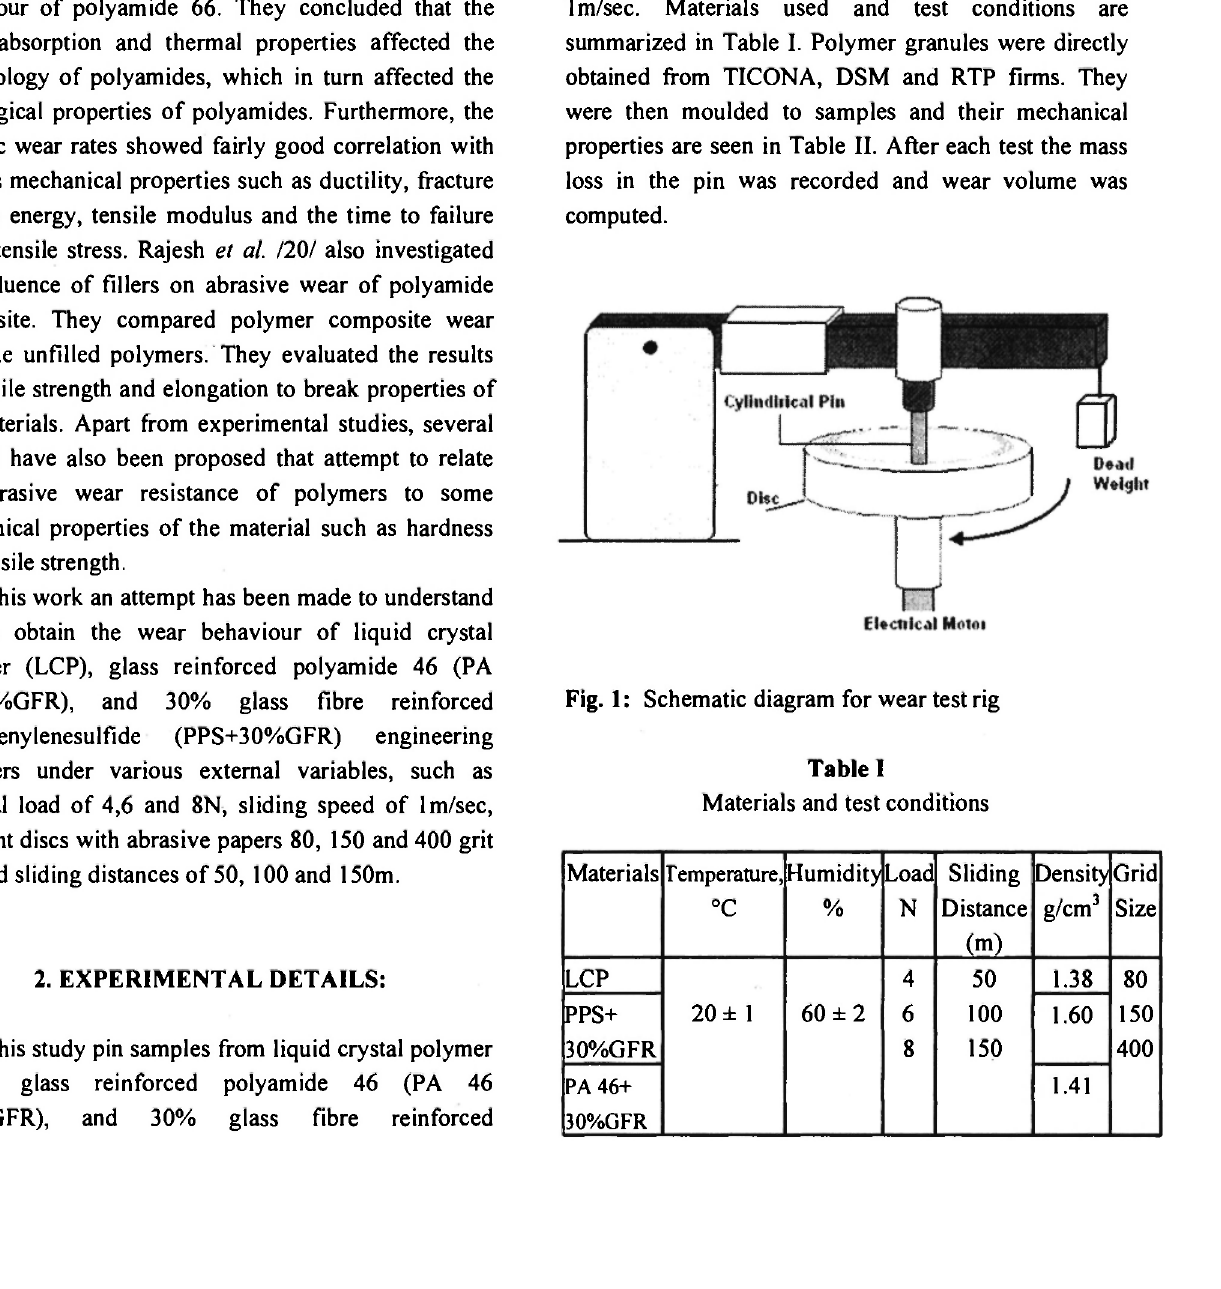
Fig. 1 : Schematic diagram for wear test